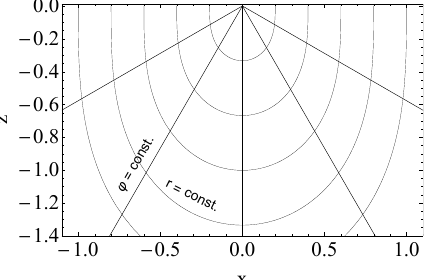
Figure 8 . Polar-like coordinate system. Constant r slices follow the shapes of static